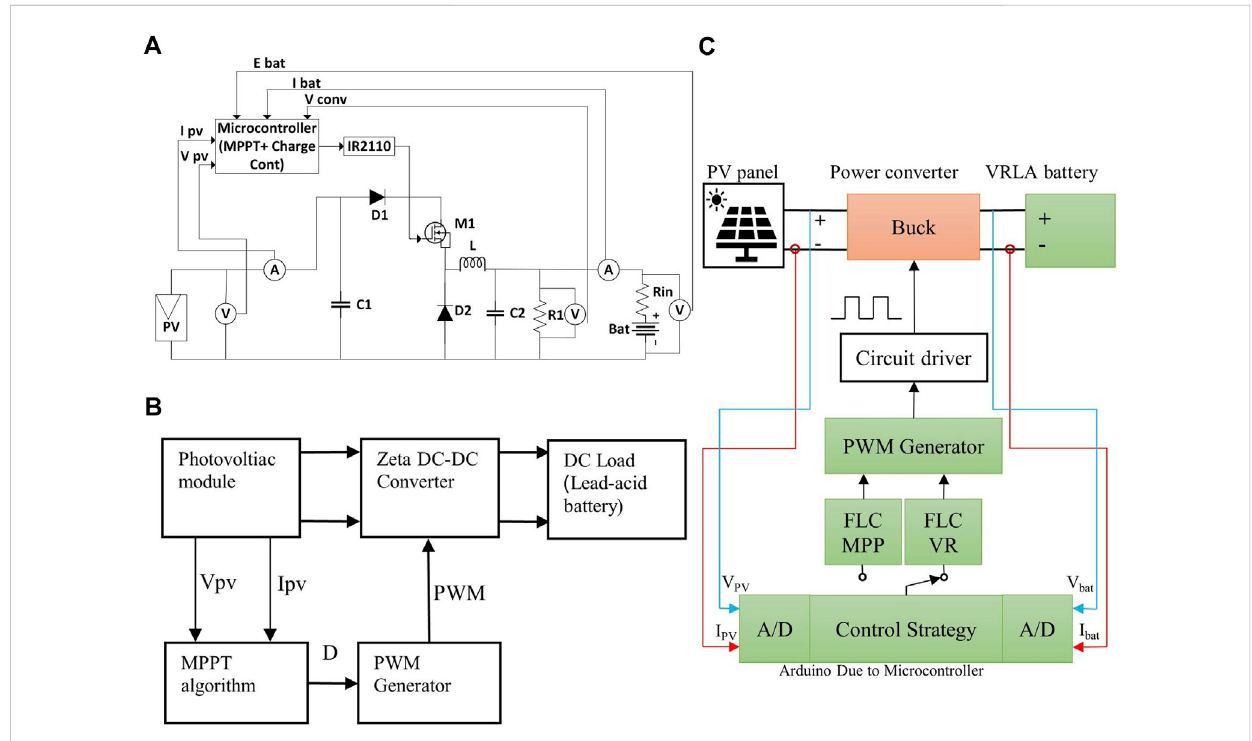
FIGURE 8 Schematic diagram for pv-battery charge controller based on (A) A three stages (bulk, absorption, and fl oat) mppt buck converter (Abdul Rahman et al., 2020). (B) P&O-based MPPT-based Zeta converter (Ananda-Rao et al., 2020b). (C) Buck converter, two FLCs MPPT (Seguel and Seleme,